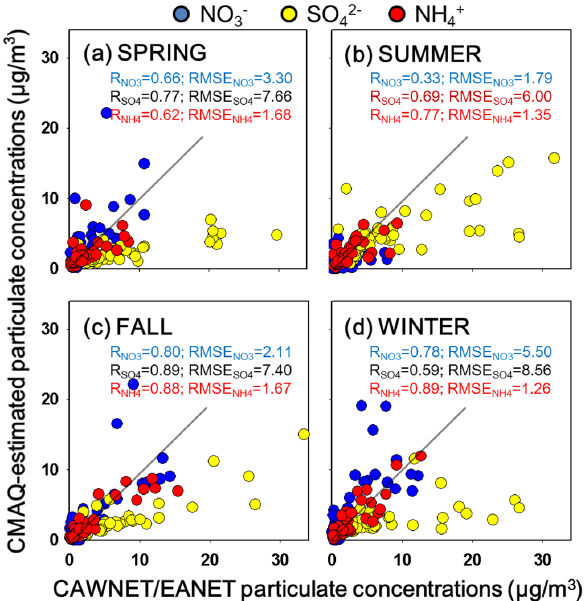
Fig. 8. Scatter plots of CMAQ-estimated and EANET/CAWNET- derived particulate concentrations of NO − , SO 2 − , and NH + for the 3 4 4 four seasons of 2006. Blue, yellow, and red circles indicate concen- trations of NO − , SO 2 − , and NH + , respectively: (a) spring, (b) sum- 3 4 4 mer, (c) fall, and (d)